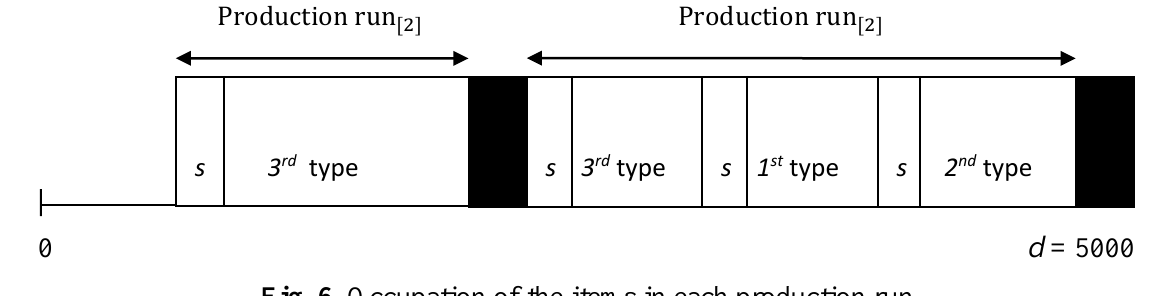
Fig. 6. Occupation of the items in each production